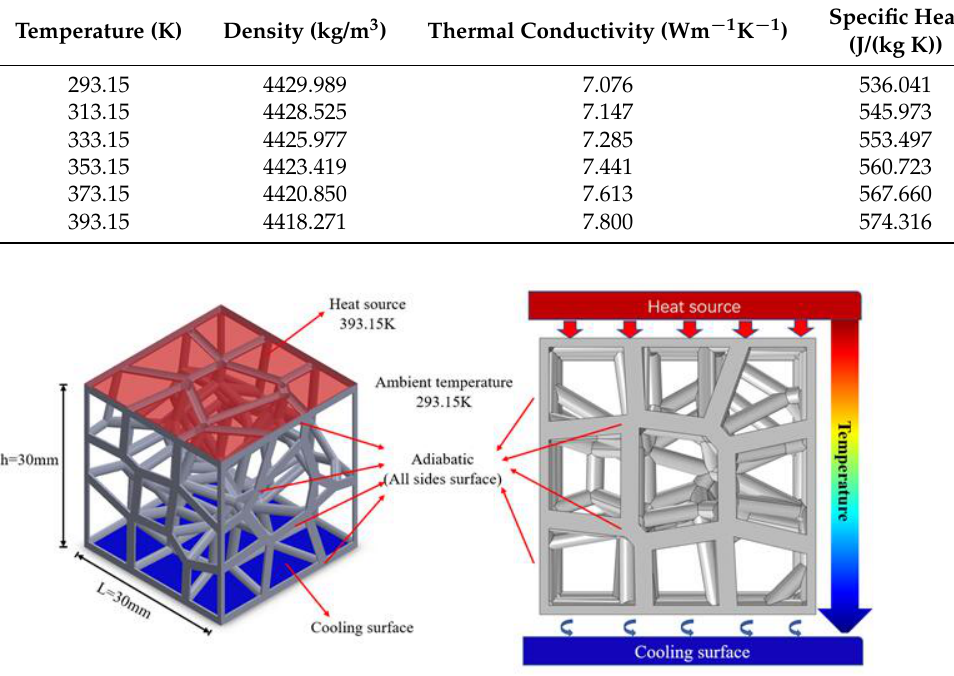
Figure 5. The temperature loading and boundary conditions of thermal simulation of GV3 structures.